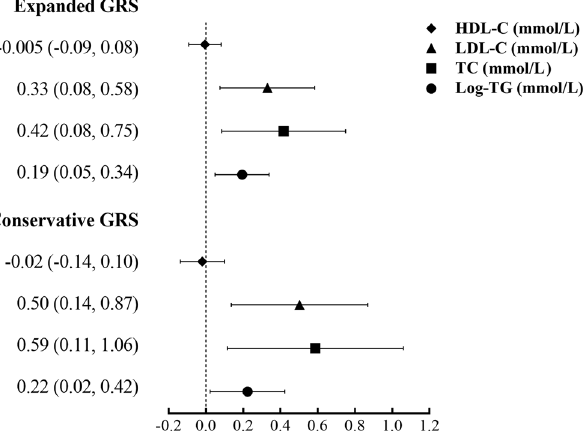
Figure 1. Forest plot for the causal association of HbA1c with lipids (mmol/L) by Expanded and Conservative GRSs. Statistics were presented as β coefficients and 95% confidential levels (CIs) of MR estimators; all data were calculated under the ultimate model with age, sex, BMI, systolic and diastolic blood pressure, smoking and drinking status, physical activity status, and diabetes